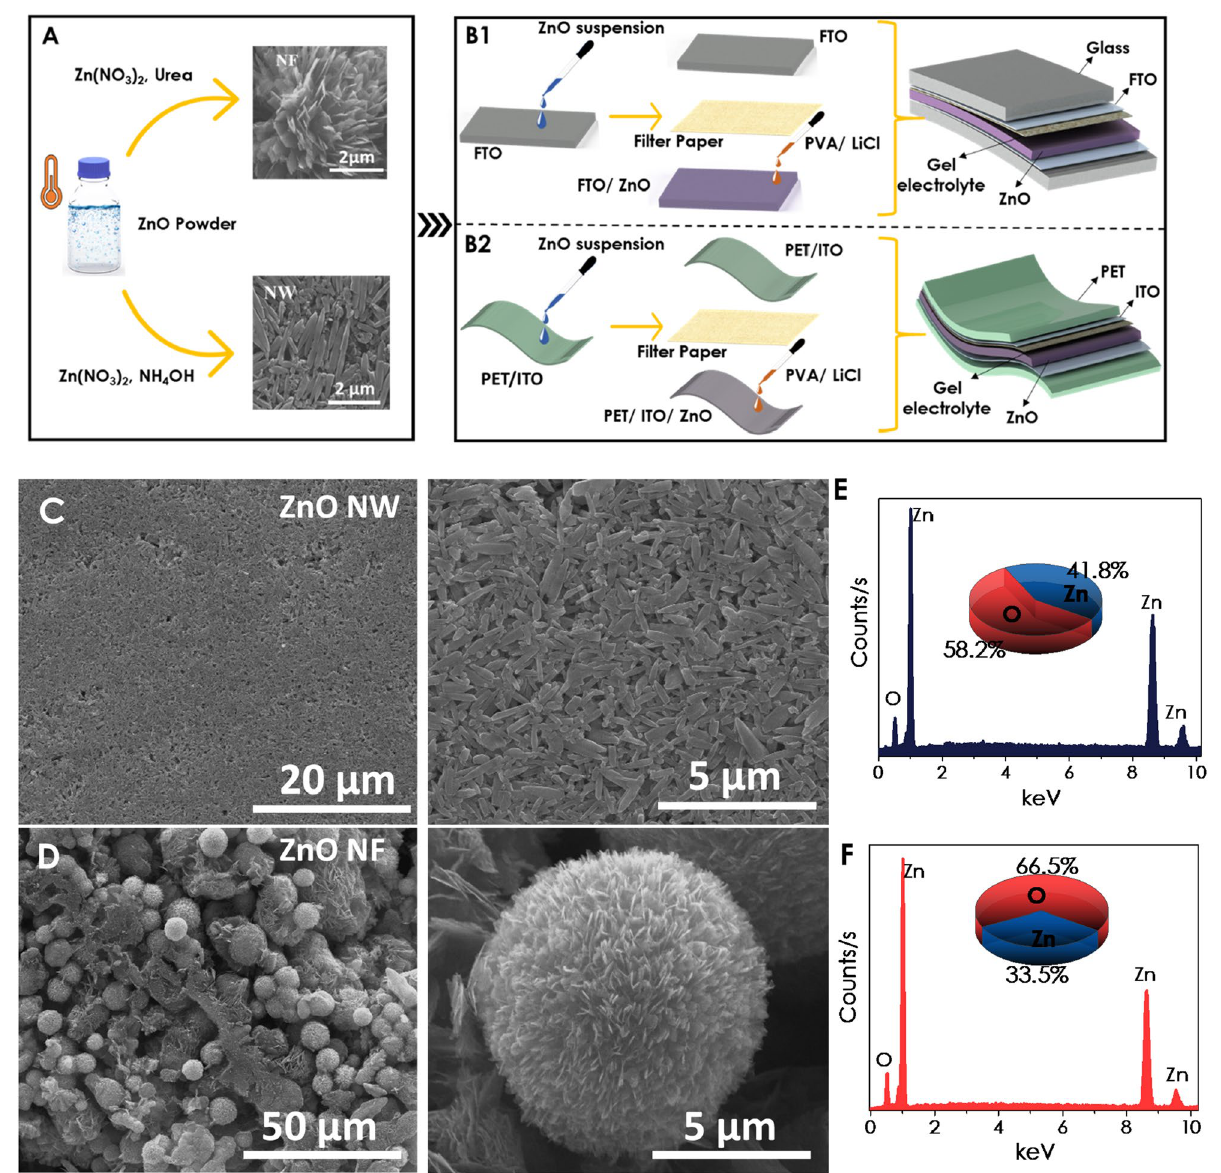
Figure 3. ( A ) Schematic demonstration for ZnO powder preparation, ( B ) the rigid and flexible P-SC assemble, respectively; ESEM images of ZnO ( C ) NW and ( D ) NF powder after spin-coated on FTO coated glass substrates; and EDX analysis results of ZnO ( E ) NW and ( F )